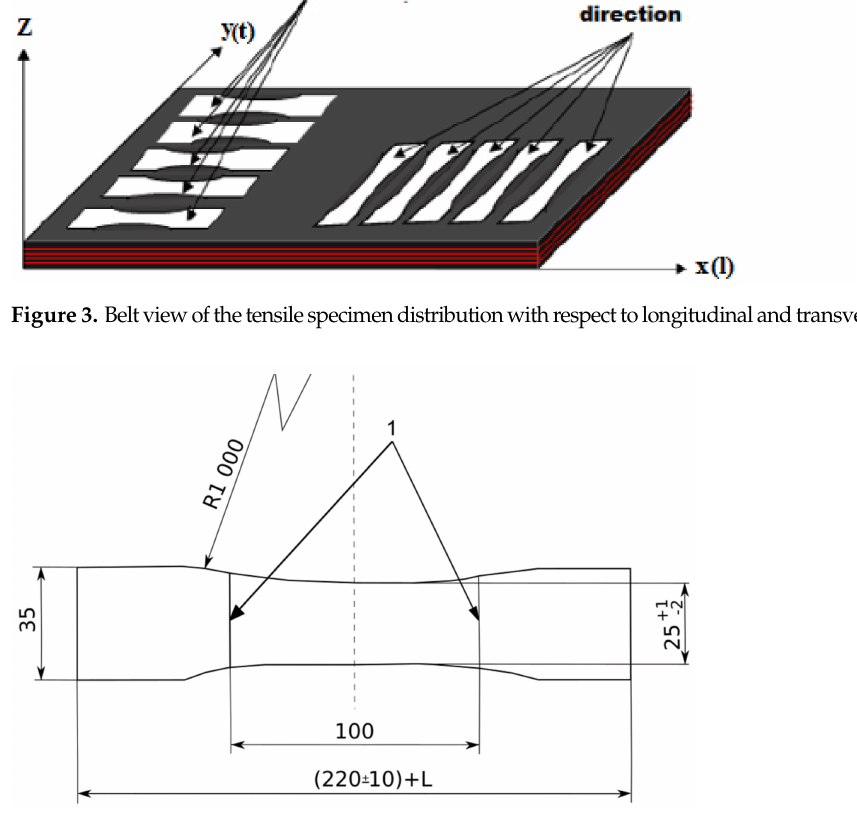
Figure 4. Standardized belt specimen for the uniaxial tensile test according to ISO